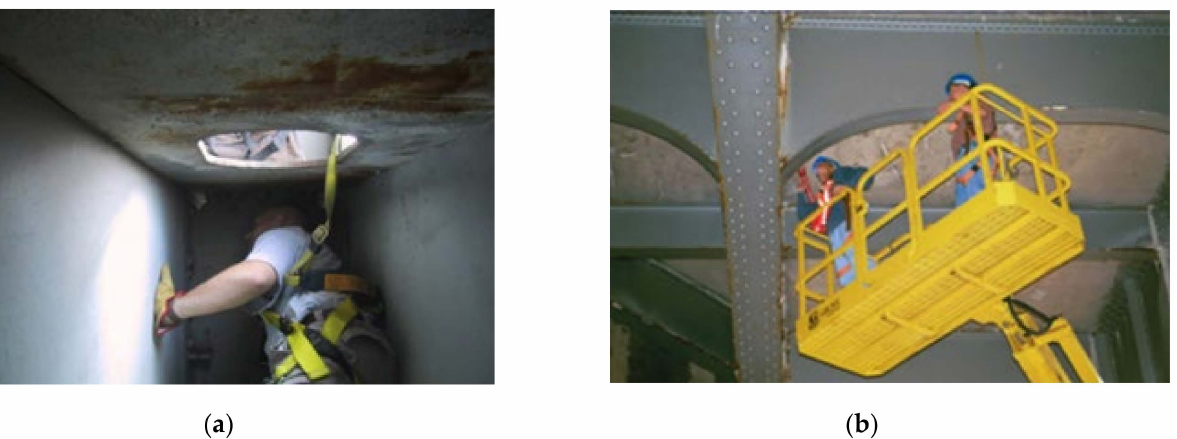
Figure 3. Challenges of visual inspection method: ( a ) Lack of lighting [10]; ( b ) Visual inspection at heights can be dangerous and challenging